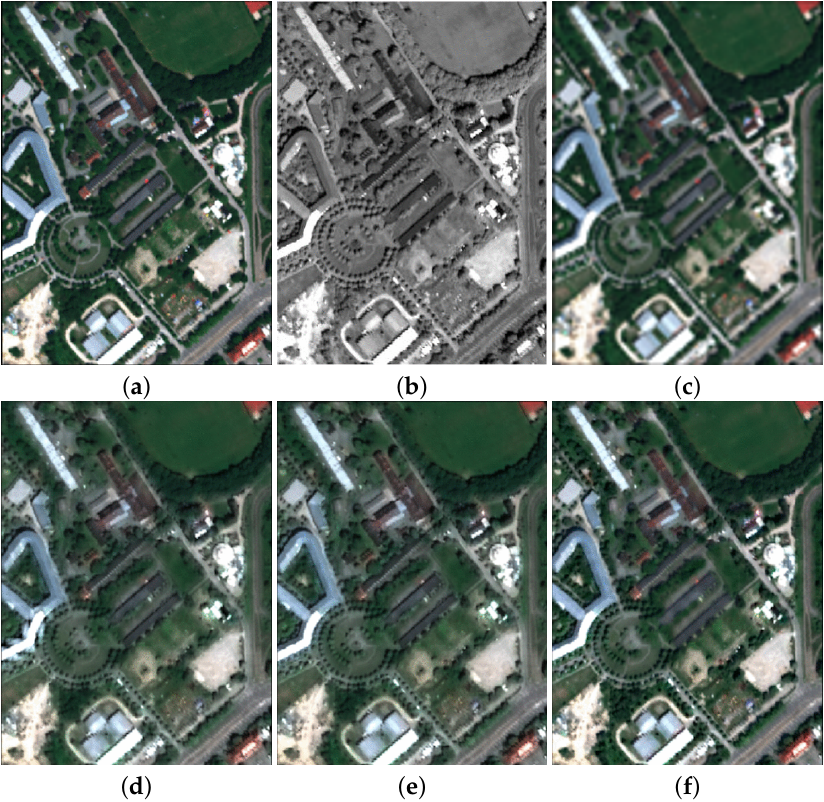
Figure 6. HySpex image results: ( a ) true-color composition of the reference 0.75-m MS image; ( b ) input 0.75-m Pan; ( c ) input 1.5-m MS; ( d ) AWLP output; ( e ) SparseFI output; ( f ) J-SparseFI output